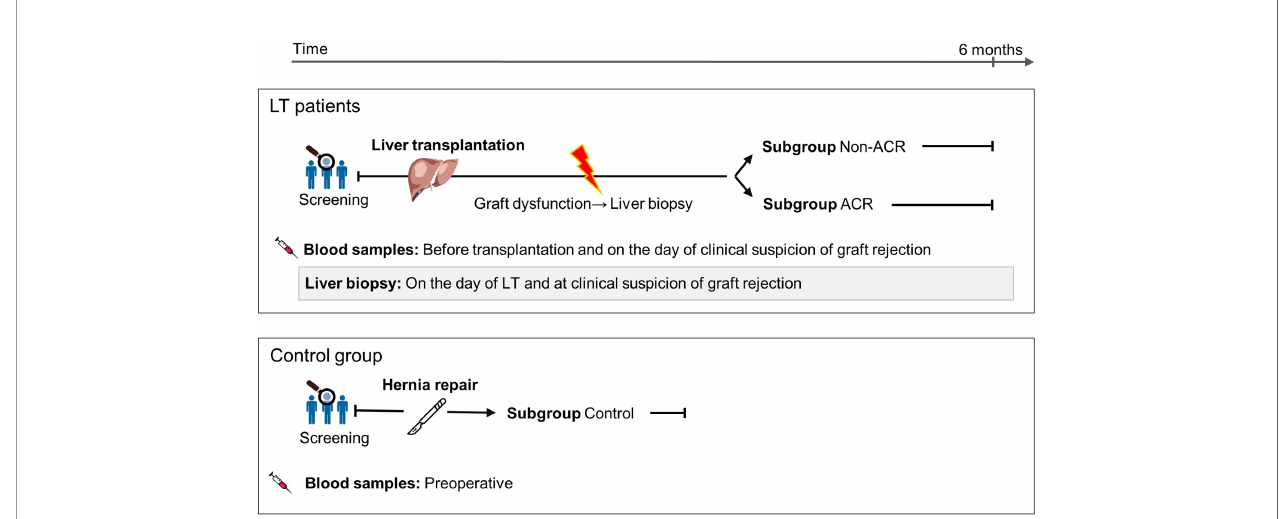
FIGURE 3 | Study cohort description and patient sample classi fi cation for a EP diagnostic accuracy study on ACR following LT. Blood samples were obtained, accompanied by LBs due to suspicion of ACR based on abnormal liver parameters such as elevated bilirubin and transaminase levels or deterioration of synthetic liver function. Samples and patients were divided into ACR and non-ACR subgroups according to their biopsy result. The control group comprised patients with a symptomatic hernia, and their blood samples were collected before hernia